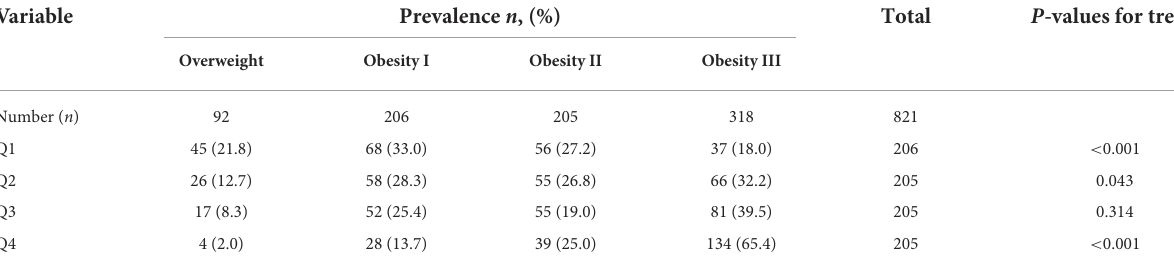
TABLE 5 Prevalence of overweight, obesity I, obesity II, and obesity III between the SUA quartiles.